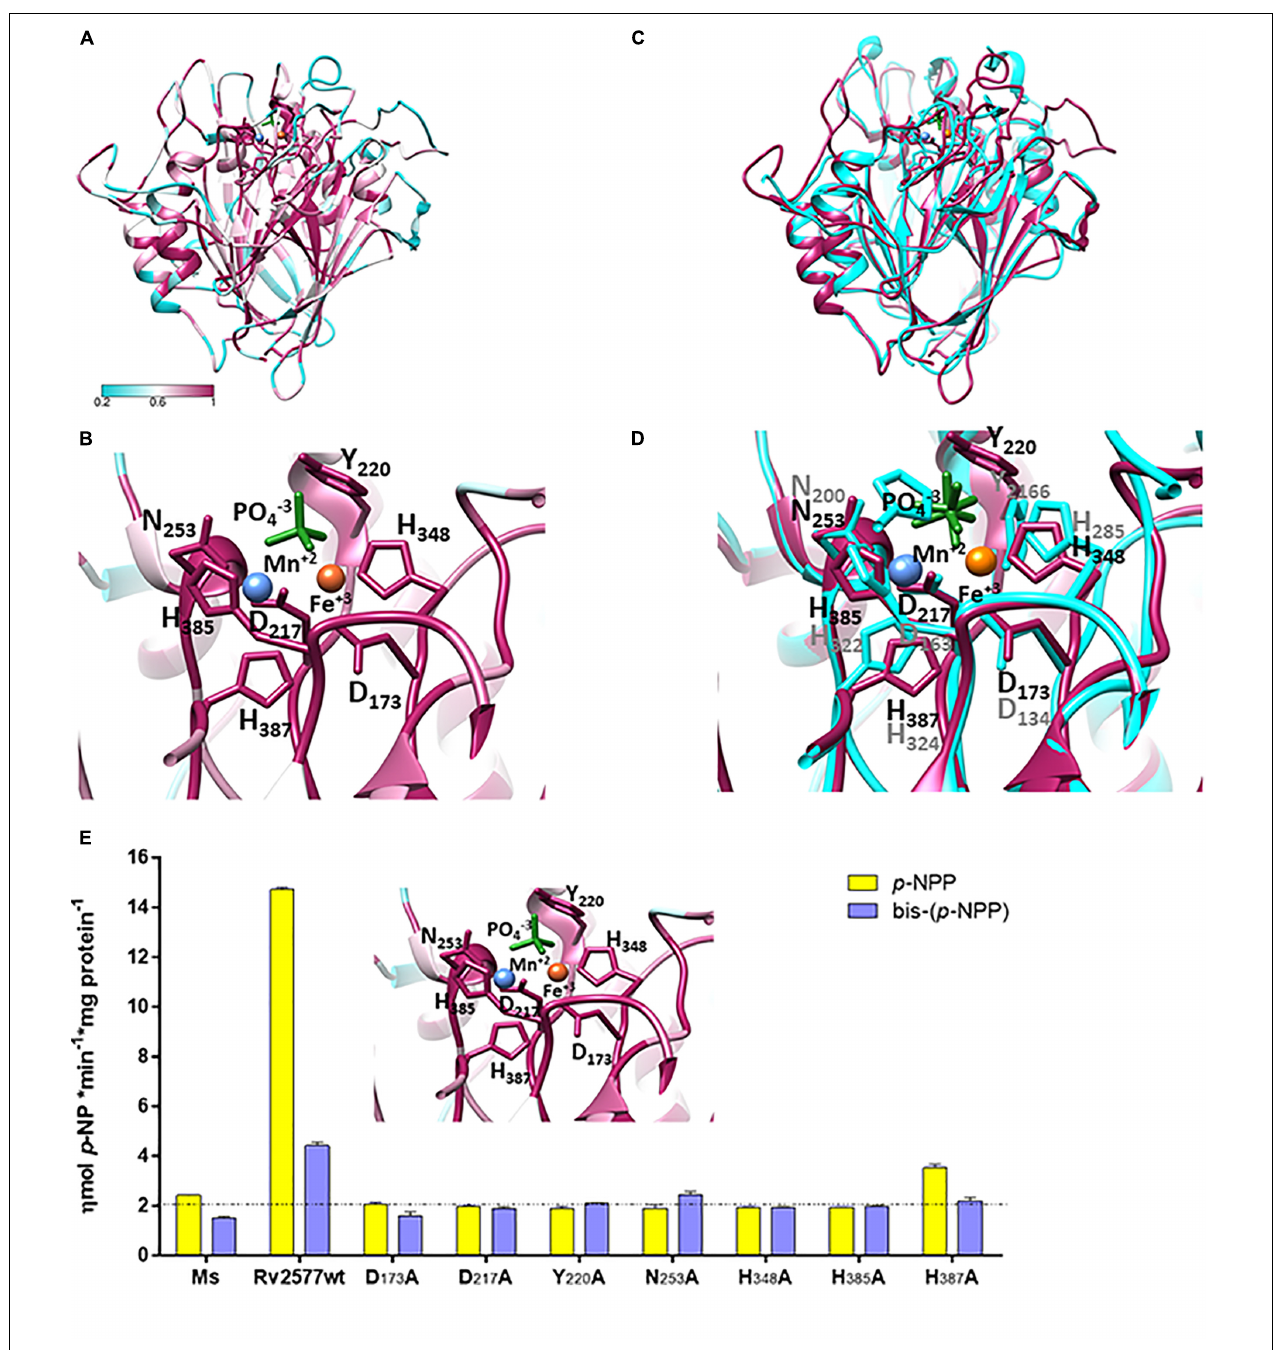
FIGURE 2 | Rv2577 has a similar 3D structural model than that of the purpura acid phosphatases, with similar active site residues, as well, that are critical for catalysis. (A) The molecular model of Rv2577 based on sequences of 150 analogous proteins, including the top structure template of Ipomoea batata PAP (PDB 1XZW), alkaline prokaryotic and acid eukaryotic phosphatases. The color variation determines the degree of conservation of amino acid residues from minor (cyan) to major (magenta). (B) The catalytic site of Rv2577 is supported by residues D 173 , D 217 , Y 220 , N 253 , H 348 , H 385 and H 387 (represented as magenta sticks) and the divalent cations Mn + 2 (blue ball) and Fe + 3 (orange ball), which are part of the active site in 1XZW and are conserved in Rv2577. A phosphate group located in the active site is also represented (green sticks). (C) Overlapping structural model of Rv2577 (magenta) and 1XZW (cyan). (D) Amino acid residues that are part of the catalytic site based on (C) . (E) The proposed model (inset) was confirmed by replacement of each catalytic residue by alanine. Phosphatase and phosphodiesterase activities of the Rv2577 wild type (Rv2577wt) and Rv2577 mutants (D 173 A, D 217 A, Y 220 A, N 253 A, H 348 A, H 385 A and H 387 A) were determined against p -NPP (yellow bars) or bis-( p -NPP) (violet bars) as substrates. The dot line indicates the phosphatase and phosphodiesterase basal activities of soluble fraction of proteins from M. smegmatis wild type as negative control.